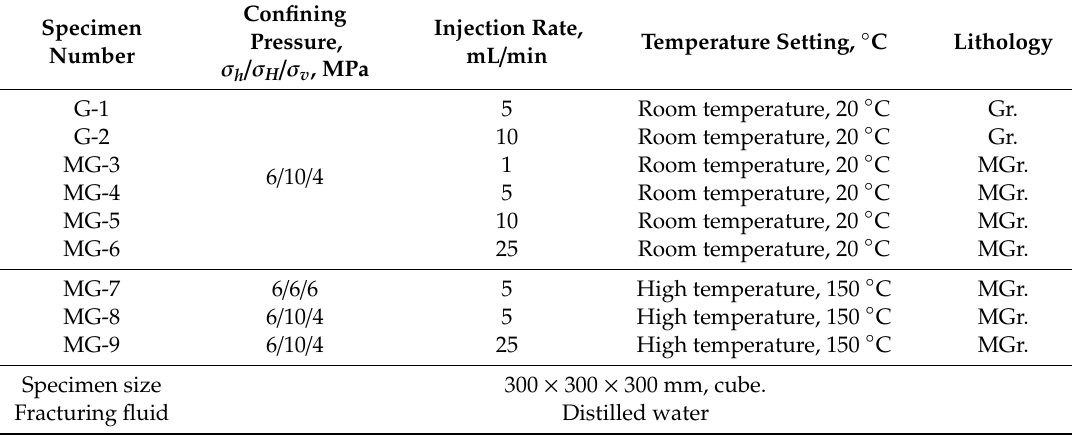
Granite sample hydraulic fracturing test conditions; Gr. is granodiorite and MGr. is